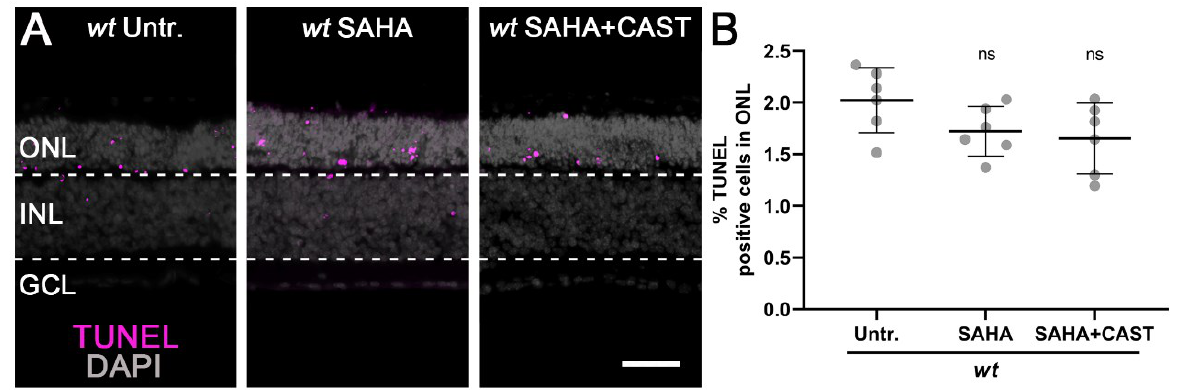
Figure A2. Combined treatment with SAHA and CAST does not negatively affect wild-type retina. Retinal explants derived from wild-type (wt) mice were cultured from post-natal day 5 to 11 and exposed to either SAHA (0.1 μM) or SAHA and CAST (20 μM) combined. ( A ) The TUNEL assay (magenta) was used to label dying cells on retinal cross-sections. DAPI (grey) was used as nuclear counterstain. ( B ) Quantification of cell death in the outer nuclear layer (ONL). Neither SAHA nor SAHA and CAST combined resulted in significant changes in retinal cell death. Untr. wt : 6 explants from 6 different mice; wt SAHA: 6/6; wt SAHA + CAST: 6/6; error bars represent SD; INL = inner nuclear layer; GCL = ganglion cell layer. Scale bar = 50 μm; n.s. = not significant.